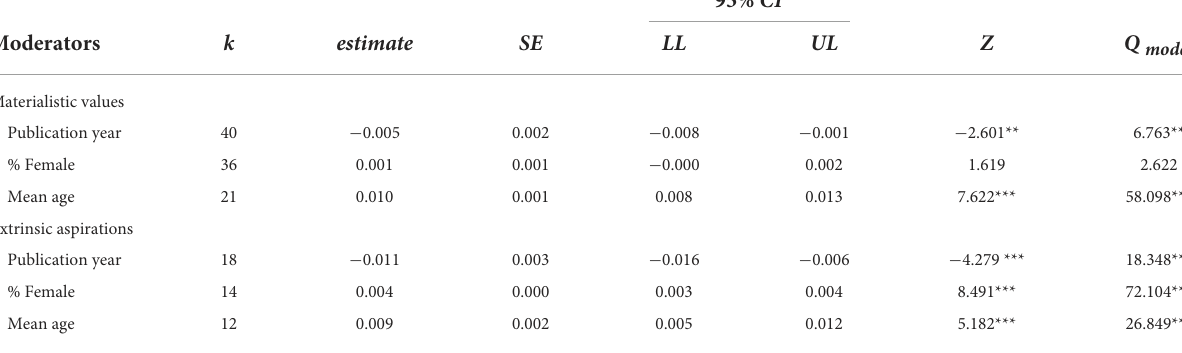
TABLE 6 Publication year, percent female, and mean age as moderators (meta-regression).